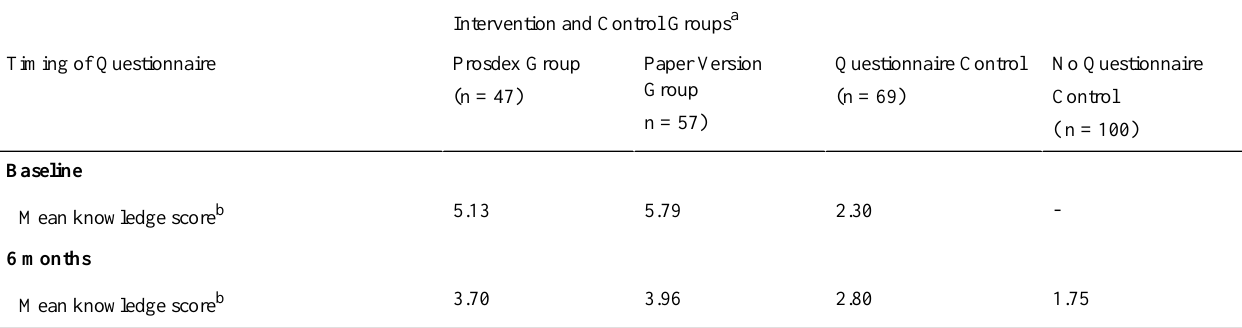
Table 6. Mean knowledge scores at baseline and at 6 months by group